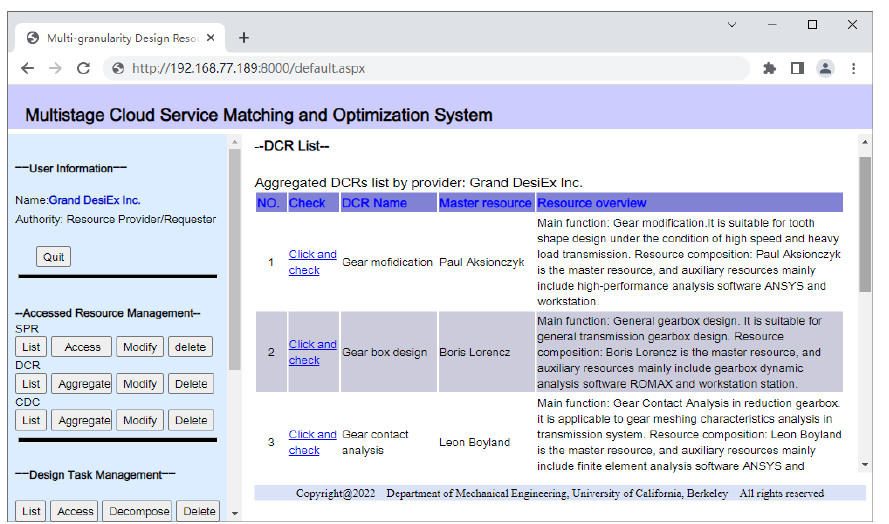
Figure 15. Process of DCR aggregation.